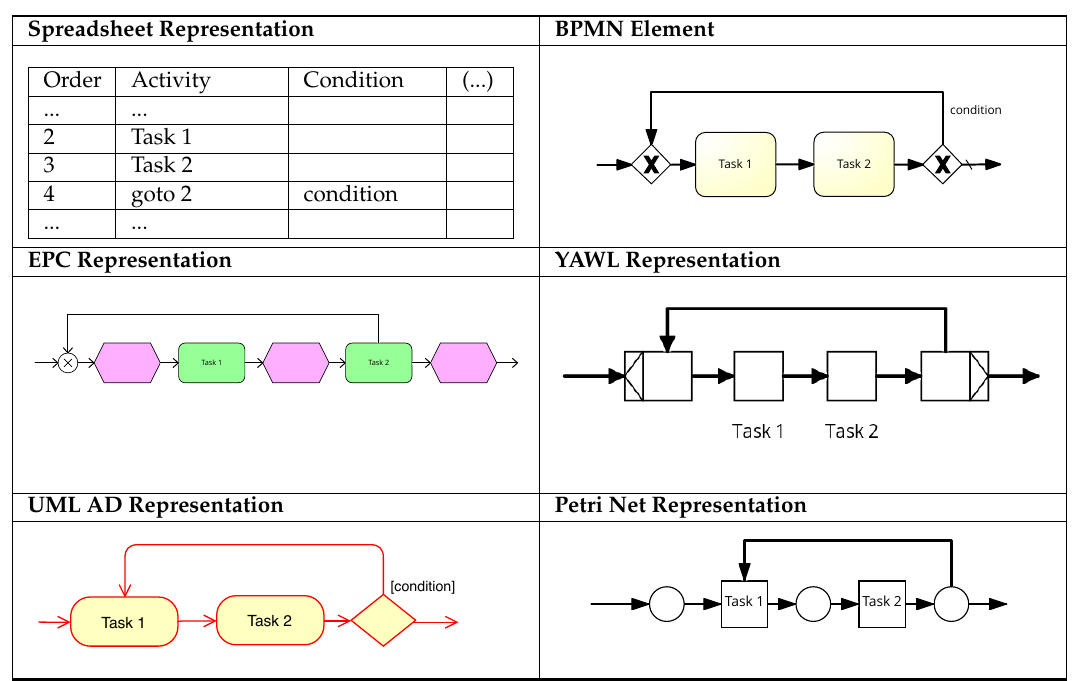
Table 13. Loop structure